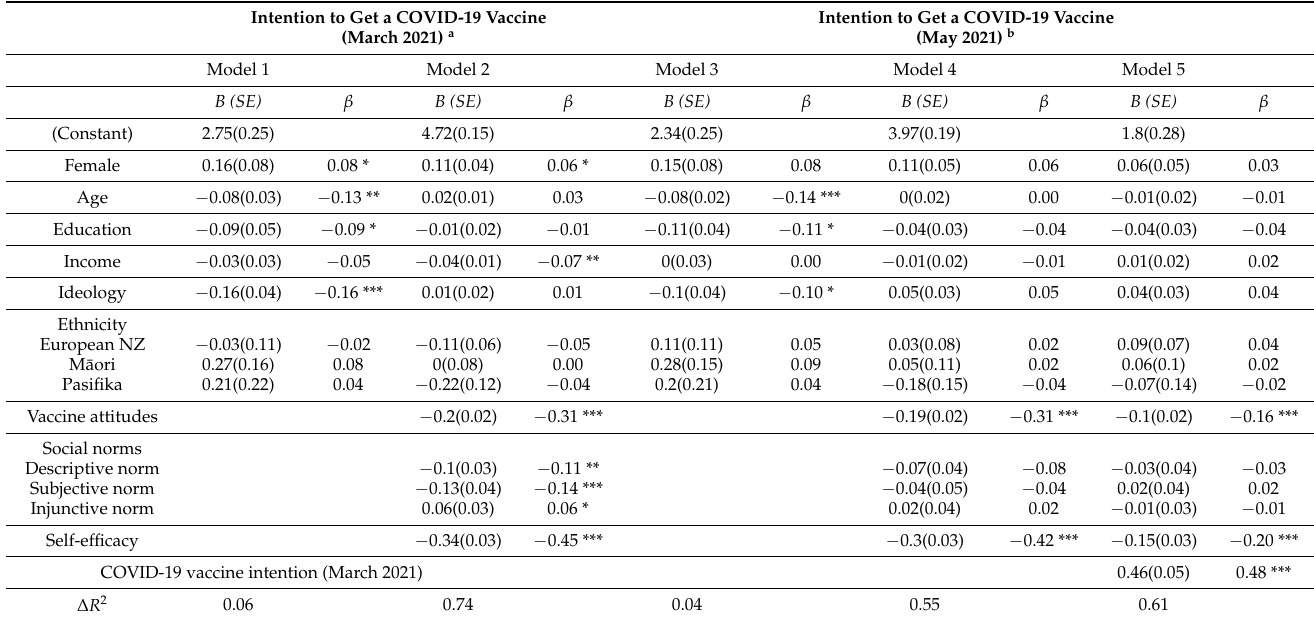
Note: n = 650. Female compared to male. Asians were the reference category for ethnicity categories in the table. Higher values of COVID-19 vaccine intention represent higher vaccine hesitancy to get a vaccine. B = Unstandardized regression coefficient, SE = Standard Error, and β = Standardized regression coefficient. a Hierarchical multiple regression predicting vaccine intentions from data collected during wave 1. Model 1 outcome variable is vaccine intentions at wave 1 and predictor variables are demographic variables only. Model 2 outcome variable is vaccine intentions at wave 1 consisting of demographic variables and predictor variables collected at wave 1. b Hierarchical multiple regression predicting vaccine intentions in wave 2 using predictor variables collected during wave 1. Model 3 outcome variable is vaccine intentions in wave 2 and predictor variables are demographic variables collected during wave 1. Model 4 and 5 represent models predicting vaccine intentions in wave 2 using demographic variables and predictor variables collected during wave